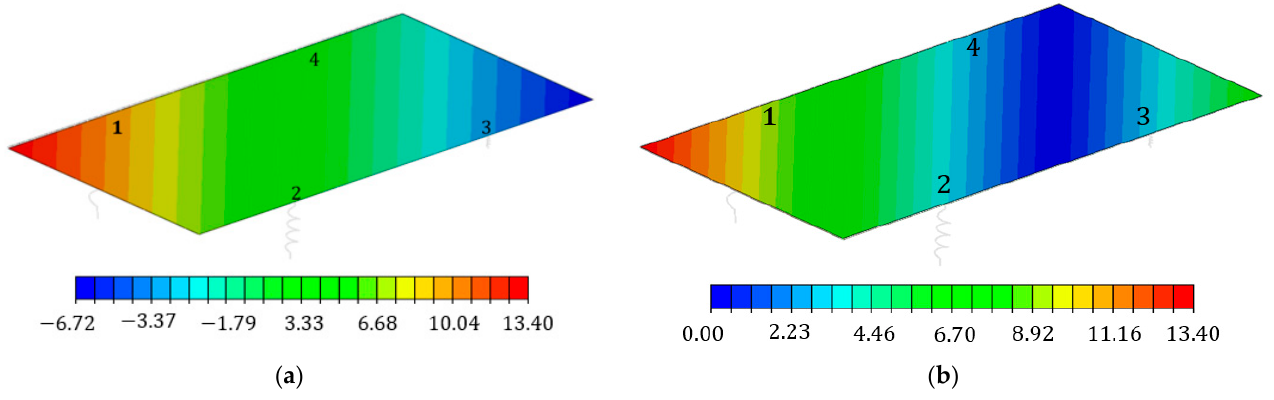
Figure 9. Displacement field distribution in mm: ( a ) along z -direction and ( b ) magnitude. Table 8. Displacement along z -direction obtained for both constraints.